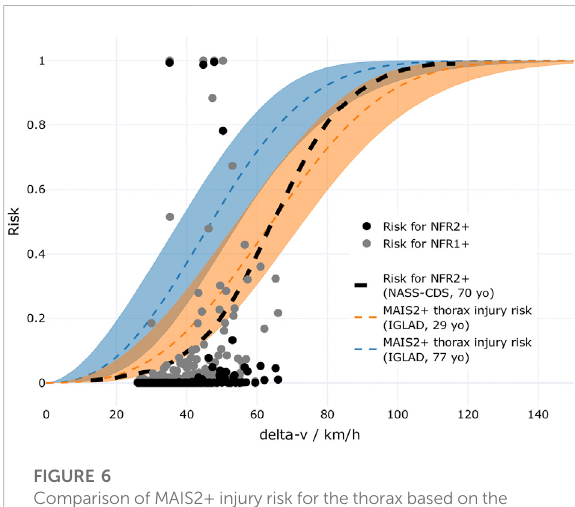
FIGURE 6 Comparison of MAIS2+ injury risk for the thorax based on the IGLAD sample (Weibull distributions for two age groups) and risks of NFR1+ and NFR2+ as a function of delta-v. The opaque areas around the curves indicate the 95th con fi dence intervals. Additionally, a risk curve for NFR2+ based on NASS-CDS data is